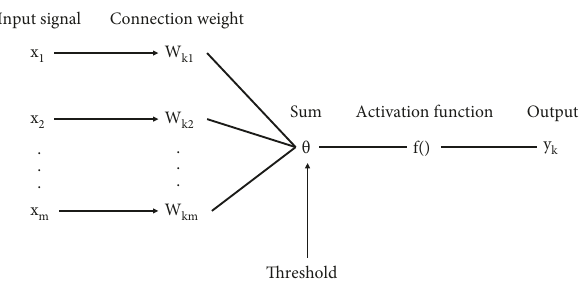
Figure 5: Neuronal model diagram. The output of the neuron is calculated by the formula: y